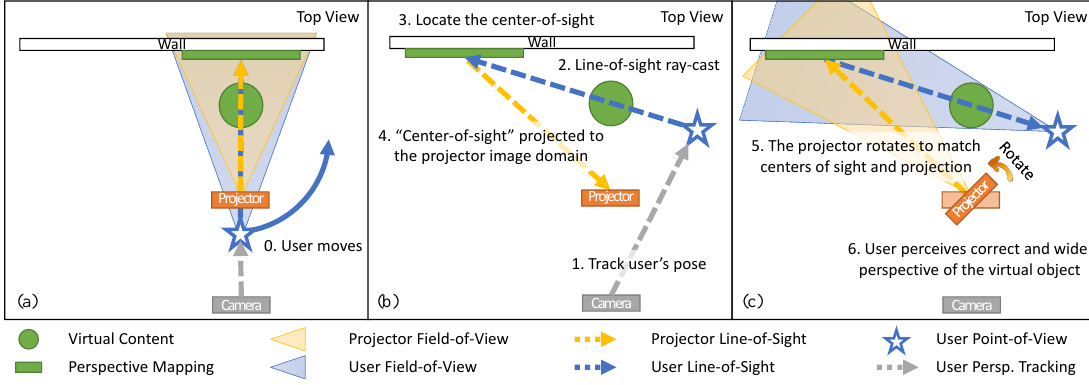
Figure 4. The illustration to demonstrate how servos are controlled to implement the actuated projection mapping. ( a ) the user’s position and perspective are tracked by the rear camera (gray arrow); ( b ) as the user inspects the virtual object (green circle), the user’s line-of-sight (blue arrow) is ray-casted to locate its view center on the surface geometry (green rectangle). The view center is projected (yellow arrow) on the projector’s image domain, and appropriate pan and tilt angles ( α , β ) are computed (Equation (3) and Figure 5); ( c ) the projector rotates to match its projection center and the user’s view center to augment more parts of the virtual object. The front camera is omitted for